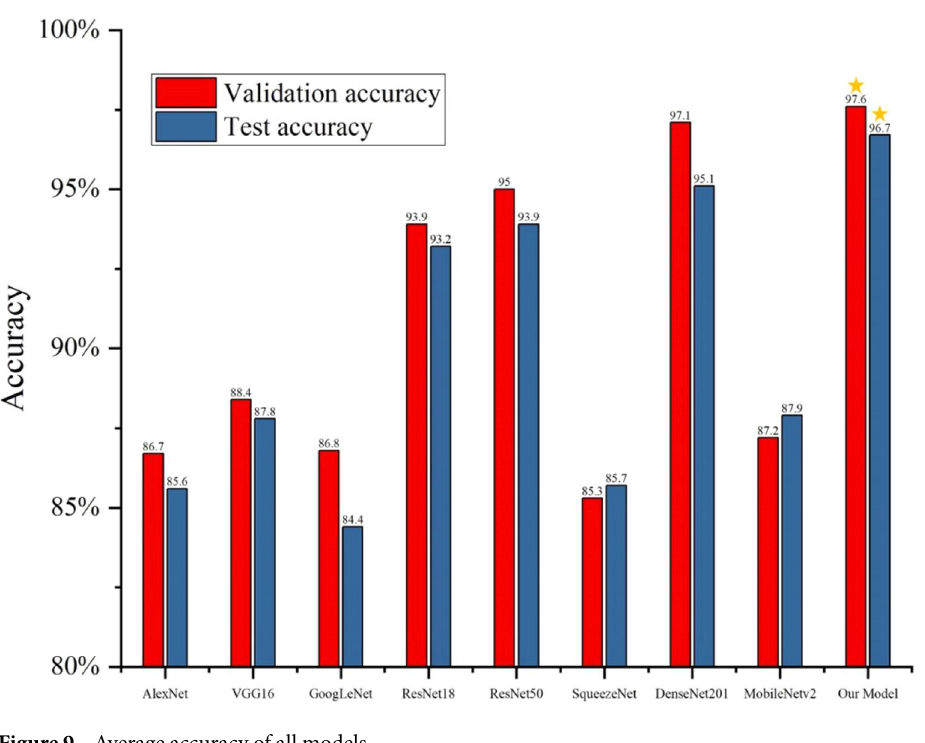
Figure 9. Average accuracy of all